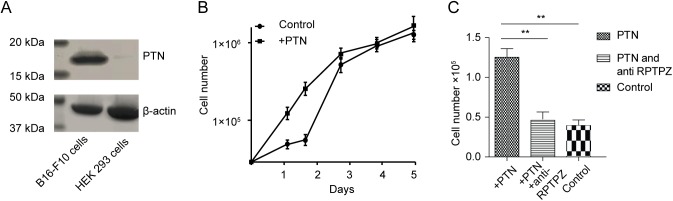
PTN expression level and its stimulation effect on the proliferation of B16-F10 melanoma cells.(A). Western-blot analysis of the expression level of PTN in B16-F10 melanoma cells and HEK293 cells. β-actin was detected as a load control. (B). Effects of recombinant PTN on B16-F10 melanoma cell proliferation. Each point represented the mean ± standard deviation of 3 replicates. PTN stimulated B16-F10 melanoma cells proliferation before the cells reached full confluency at a concentration of 100 ng/ml (P < 0.01 compared with control without adding the extracellular PTN). (C). Cells numbers of B16-F10 melanoma 24 hours after different treatments were counted and compared with the control group. Each bar represented the mean ± standard deviation of 3 replicates. Asterisks indicate statistically significant differences between samples (** p<0.01).